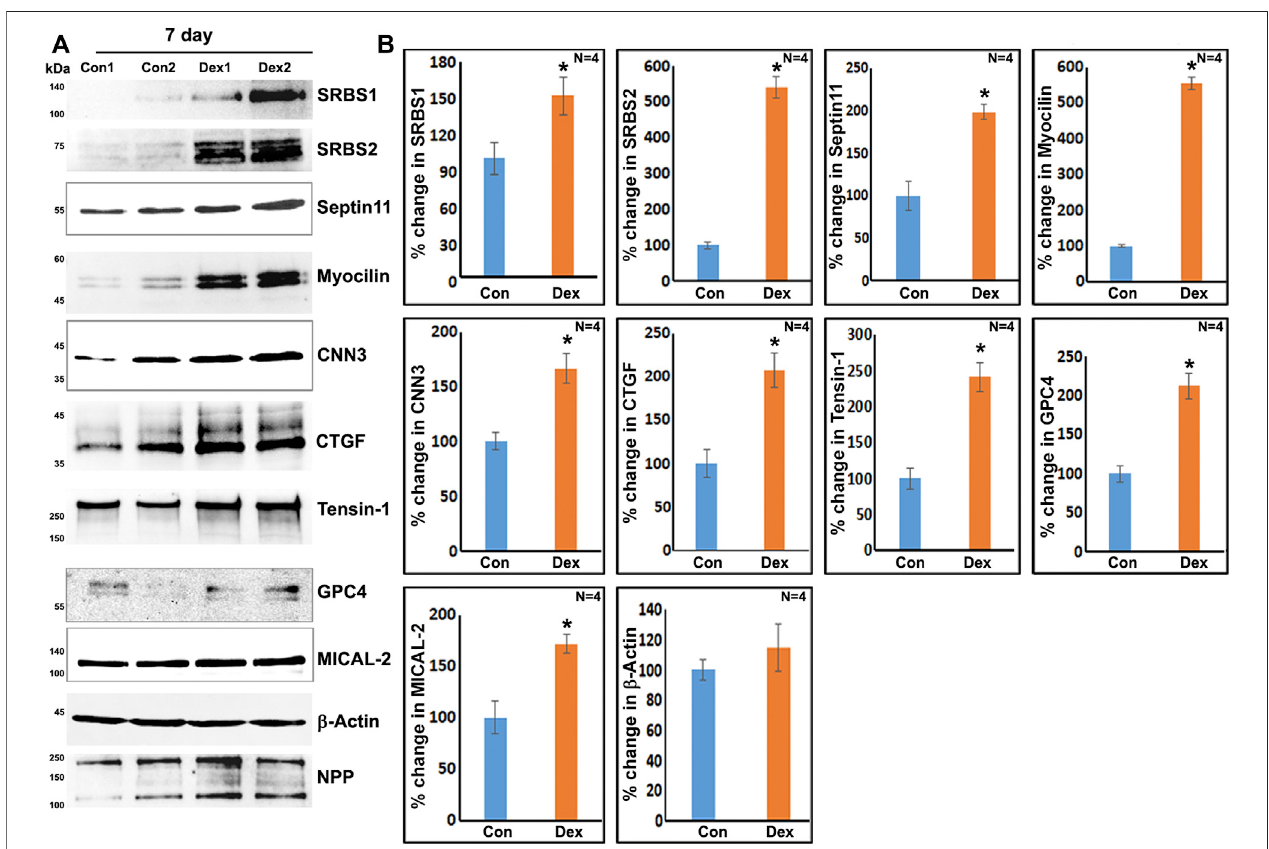
FIGURE 3 | Immunoblotting analysis based con fi rmation of elevated levels for selected proteins in the nuclear protein fraction derived from the 7-day Dex-treated humanTMcells. (A,B) showtherepresentativeimmunoblotsfortheindicatedproteinsandquantitativechangesinthelevelsoftheseproteins(histograms),respectively, in the nuclear protein fraction isolated from the TM cells treated with Dex for 7 days. p p < 0.05. n = sample number. Immunoblotted proteins were normalized to the nuclear pore protein